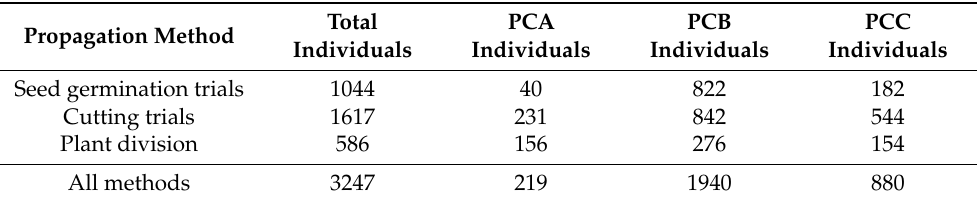
Table 3. Numbers of plant individuals raised per propagation method during ex situ conservation from priority plants (PPs) of different categories (PCA, Threatened and Near Threatened; PCB, Local Balkan endemics and subendemics; PCC, Regionally rare and/or uncommon plants) planted in awareness-raising